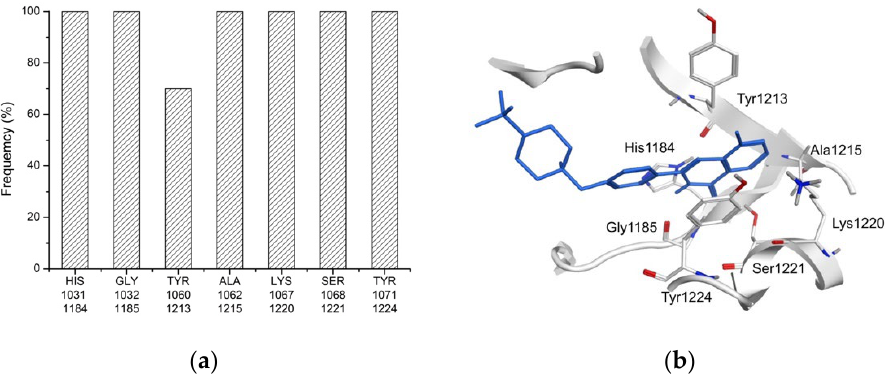
Figure 1. The critical residues of ligand binding sites on TNKS-1 and TNKS-2. ( a ) The seven critical residues determined of TNKS-1 and TNKS-2 are His1184, His1031, Gly1185, Gly1032, Tyr1213, Tyr1060, Ala1215, Ala1062, Lys1220, Lys1067, Ser1221, Ser1068, Tyr1224, Tyr1071, respectively. ( b ) Co-crystal ligand of TNKS-1 (4U6A) interact with the seven critical residues.